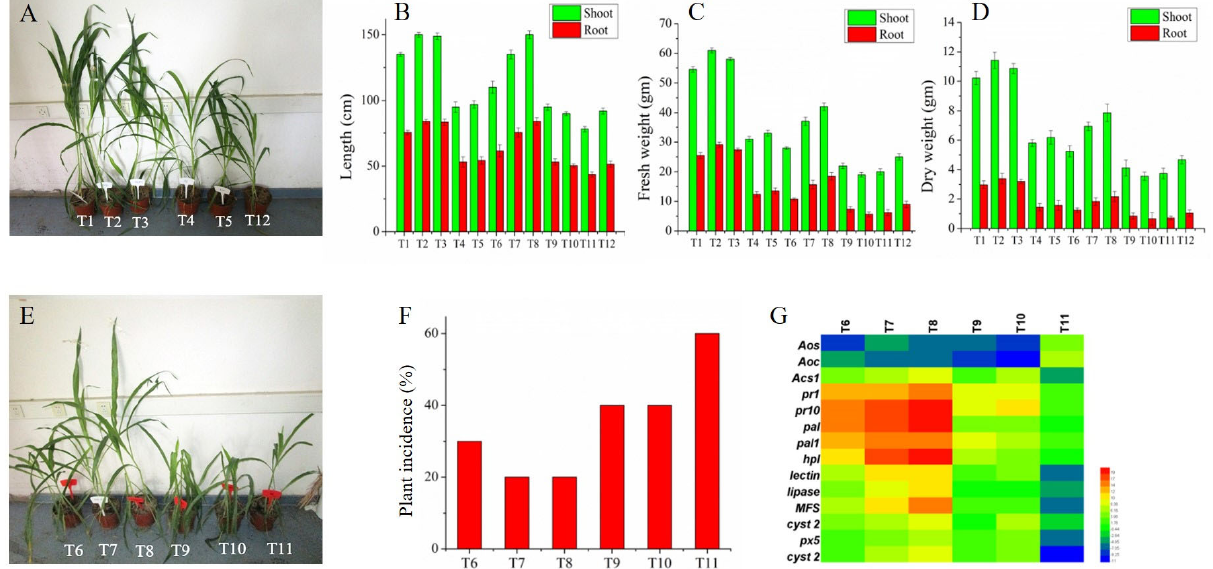
Figure 6. Influence of MUP1 gene on plant growth and biological control of F. graminearum in the greenhouse. ( A ) Maize morphology without pathogenic stress. ( B – D ) Shoot and root physiological indicators under normal and biotic stress. ( E ) Maize morphology with F. graminearum stress. ( F ) Disease index of F. graminearum infected root. ( G ) Differential expression profiles of defense-related genes in maize root tissues against F. graminearum. (T1) TAWT; (T2) OE Mup1–5 ; (T3) OE Mup1–6 ;